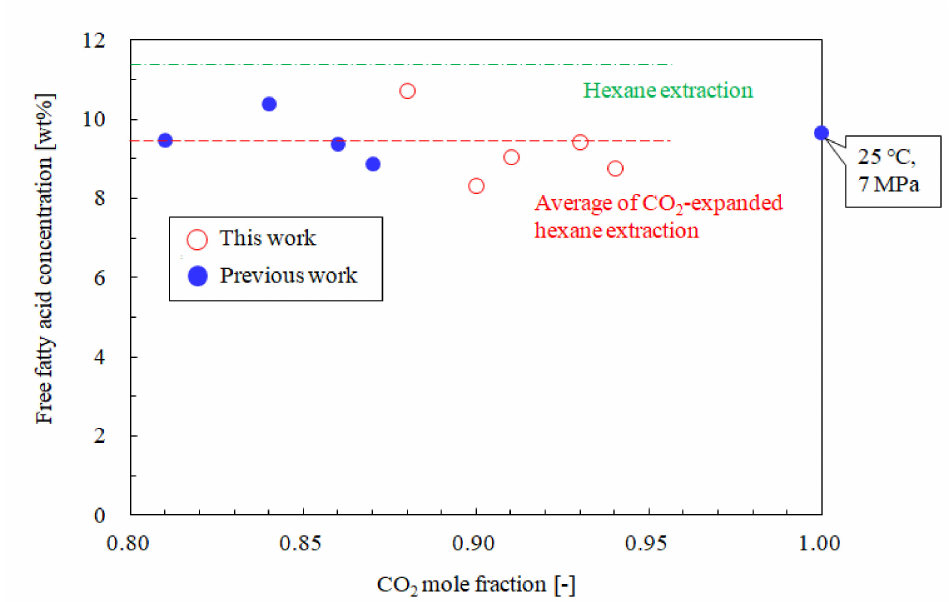
Figure 11. Relationship between the free fatty acid concentration in the extracted oil and the CO 2 mole fraction of the CO 2 -expanded hexane at 25–26 ◦ C and 5.0–5.2 MPa. Previous work is shown in ref.